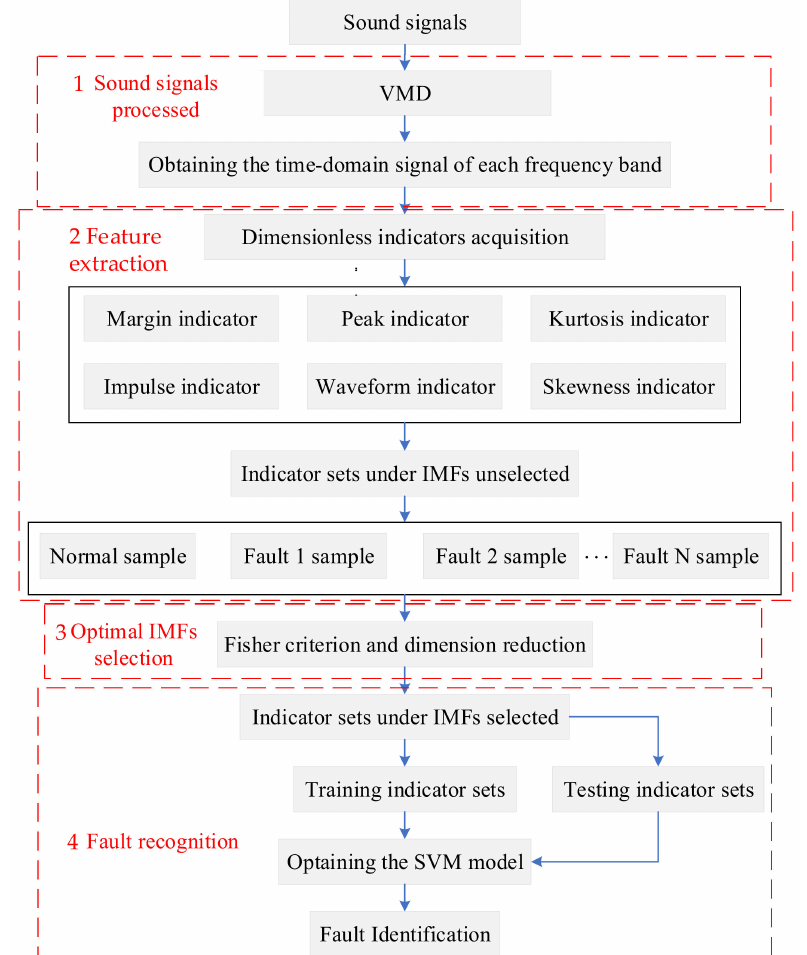
Figure 1. Diagram of the proposed